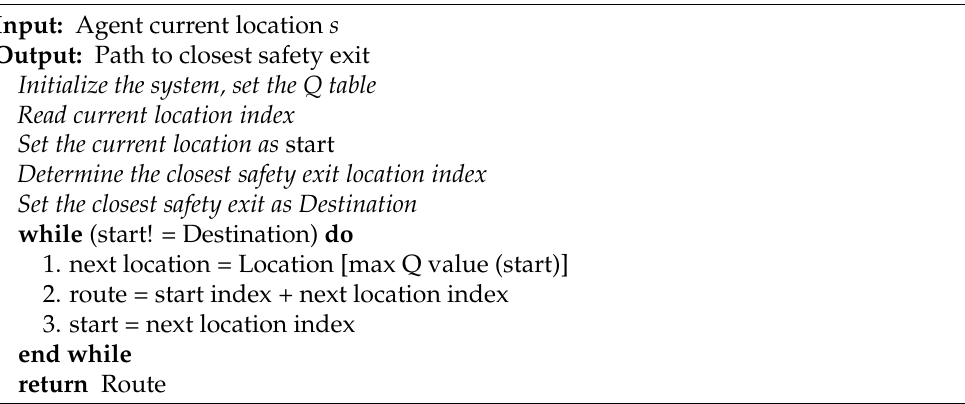
Algorithm 2 Finding the obstacle free path from the current location to the safety